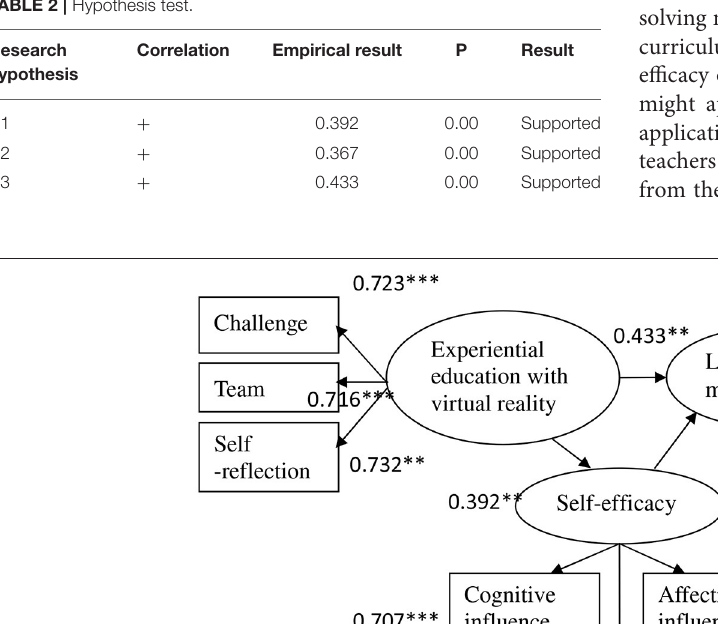
Frontiers in Psychology |